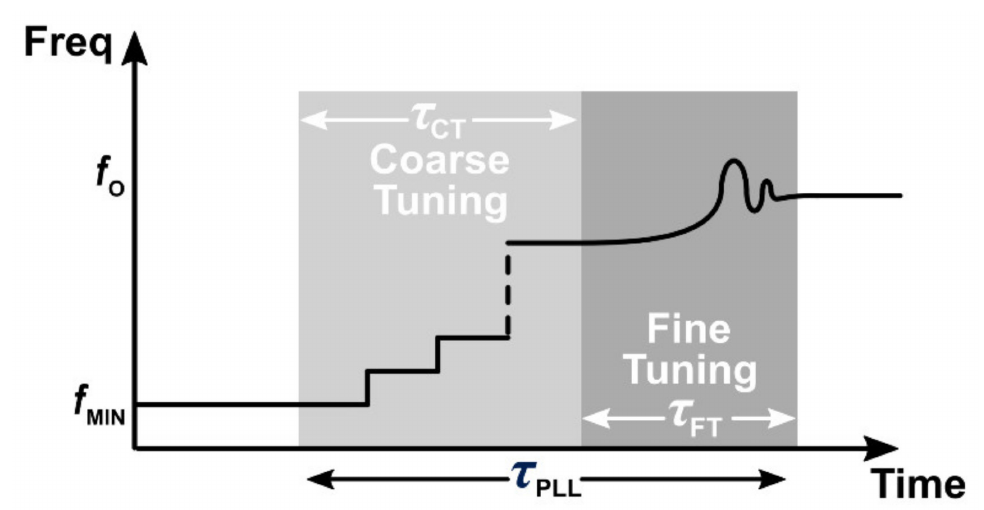
Figure 1. Typical transient response of an SC-based